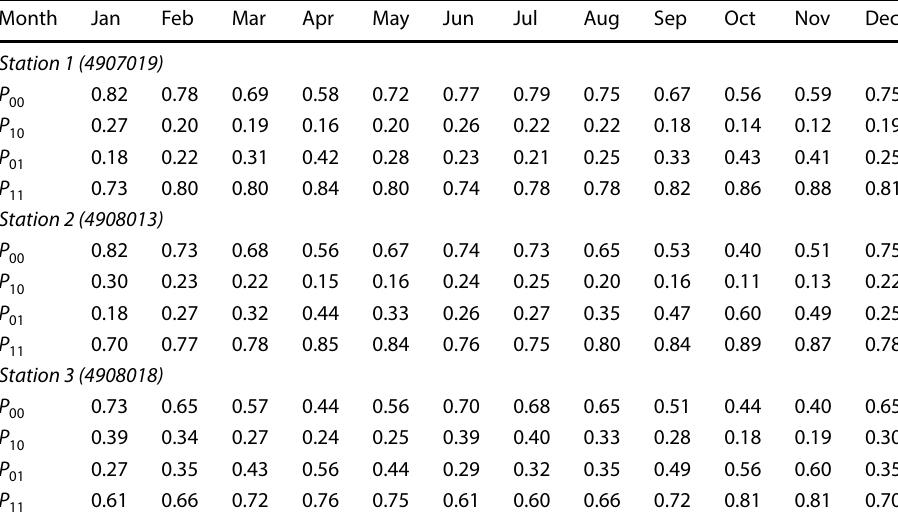
Table 4 Estimation of transition probabilities of observed rainfall for different months and stations